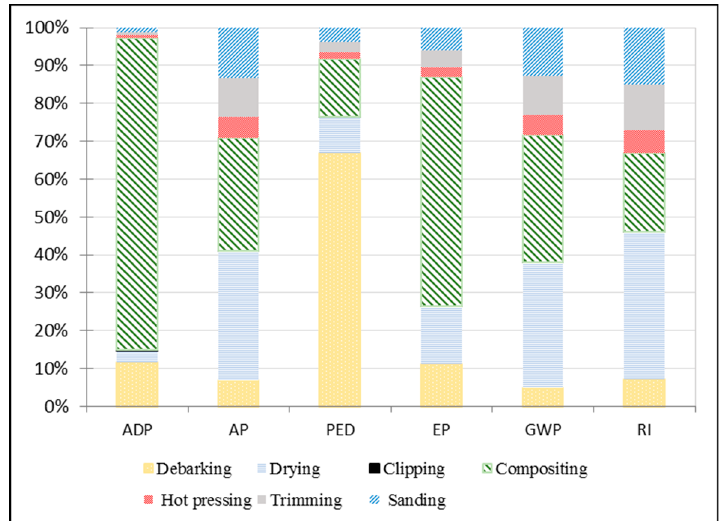
Figure 2. Contribution per subsystem (in %) to each impact category.